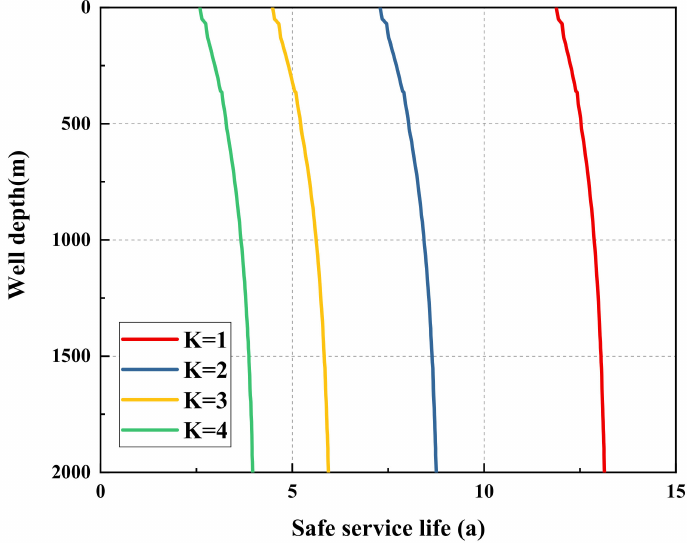
Figure 15. Influence of the stress concentration coefficient on the corrosion life of the inner layer of the string.